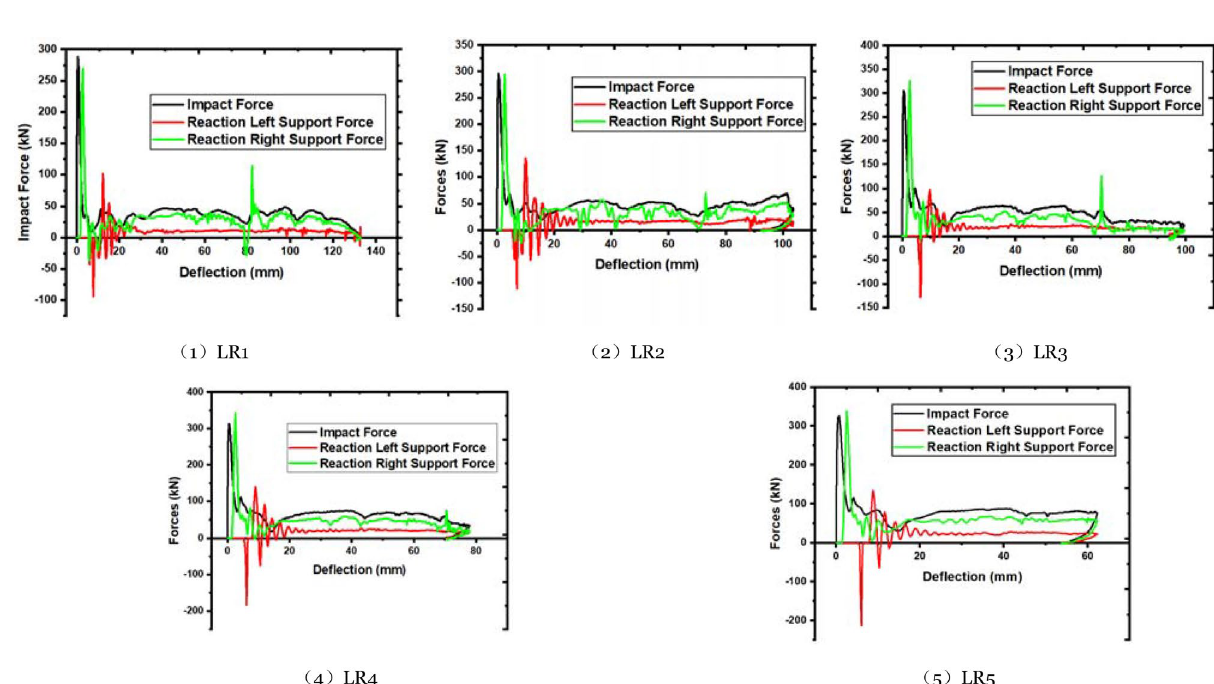
Figure 11. Force–deflection curve of members with different longitudinal reinforcement ratios.